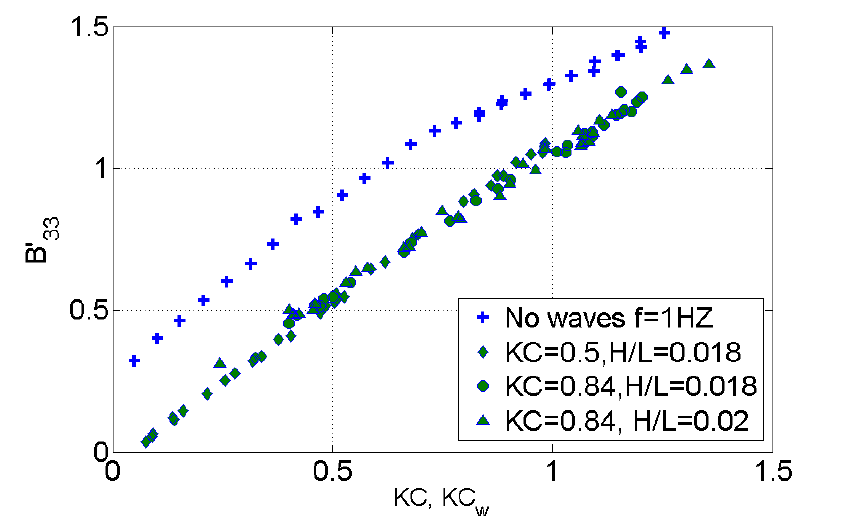
Figure 9. Comparison of the damping coefficients in waves vs. KC w with those in still water vs. KC